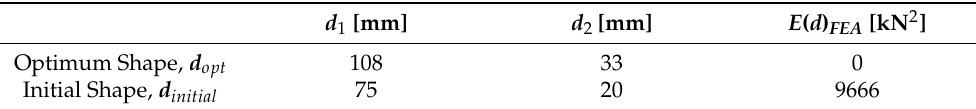
Table 2. Calculated cost function value in different design points. d 1 [mm] d 2 [mm] E ( d ) FEA [kN 2 ] Optimum Shape, d opt 108 0